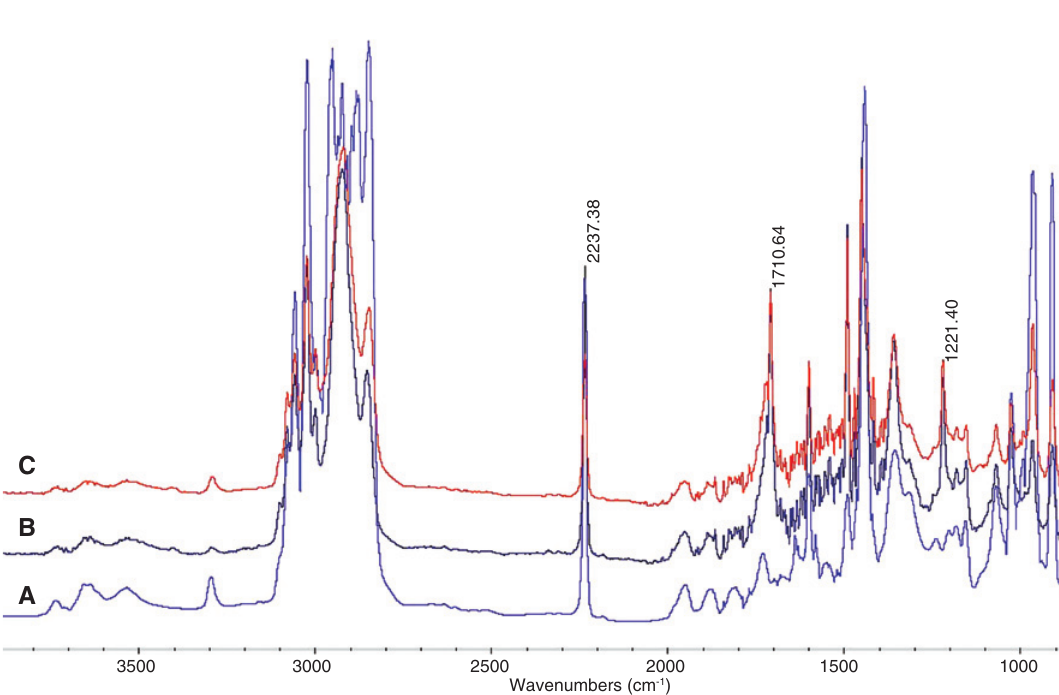
Figure 1 Infrared spectra of ABS, ABS-g-GMA, and ABS-g-GMA/St. (A) ABS, (B) ABS-g-GMA, (C)